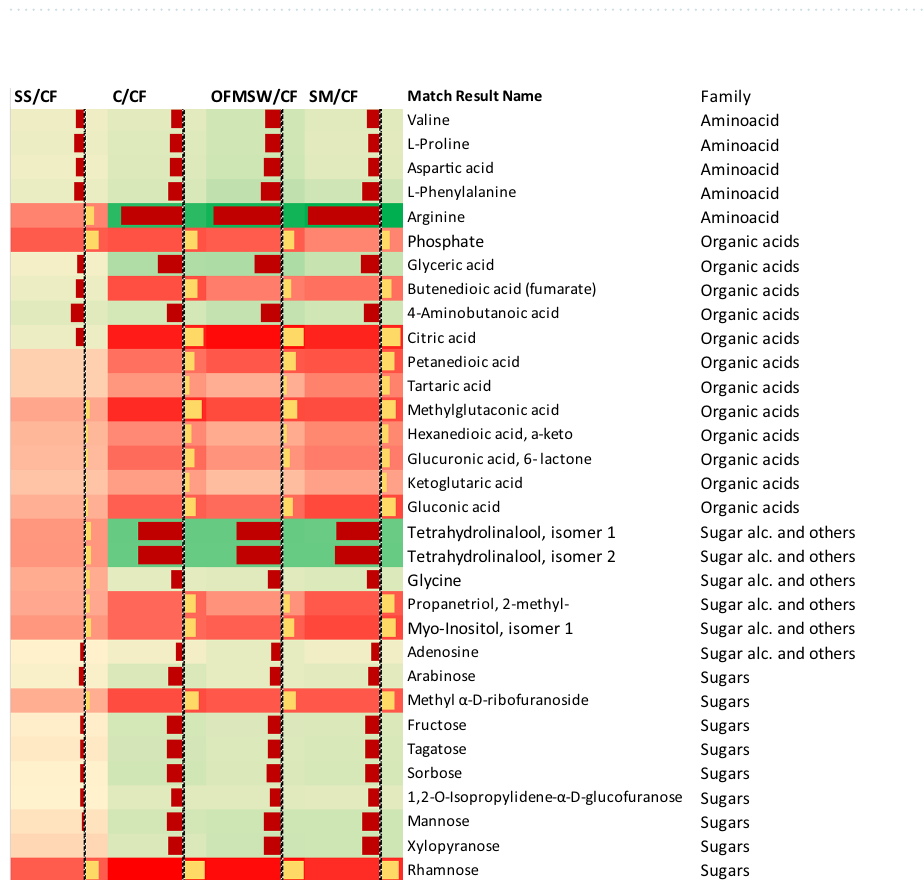
Table 3. VIP scores showing the correlation of the metabolites vs. agronomic parameters (PLS analysis). VIP scores > 1.5 were considered. a Isomers, same mas spectrum. VIP scores > 1 are shown in bold. Unknown metabolites (RI/SI < 500) are not included. Statistical analysis were conducted using XLSTAT software.